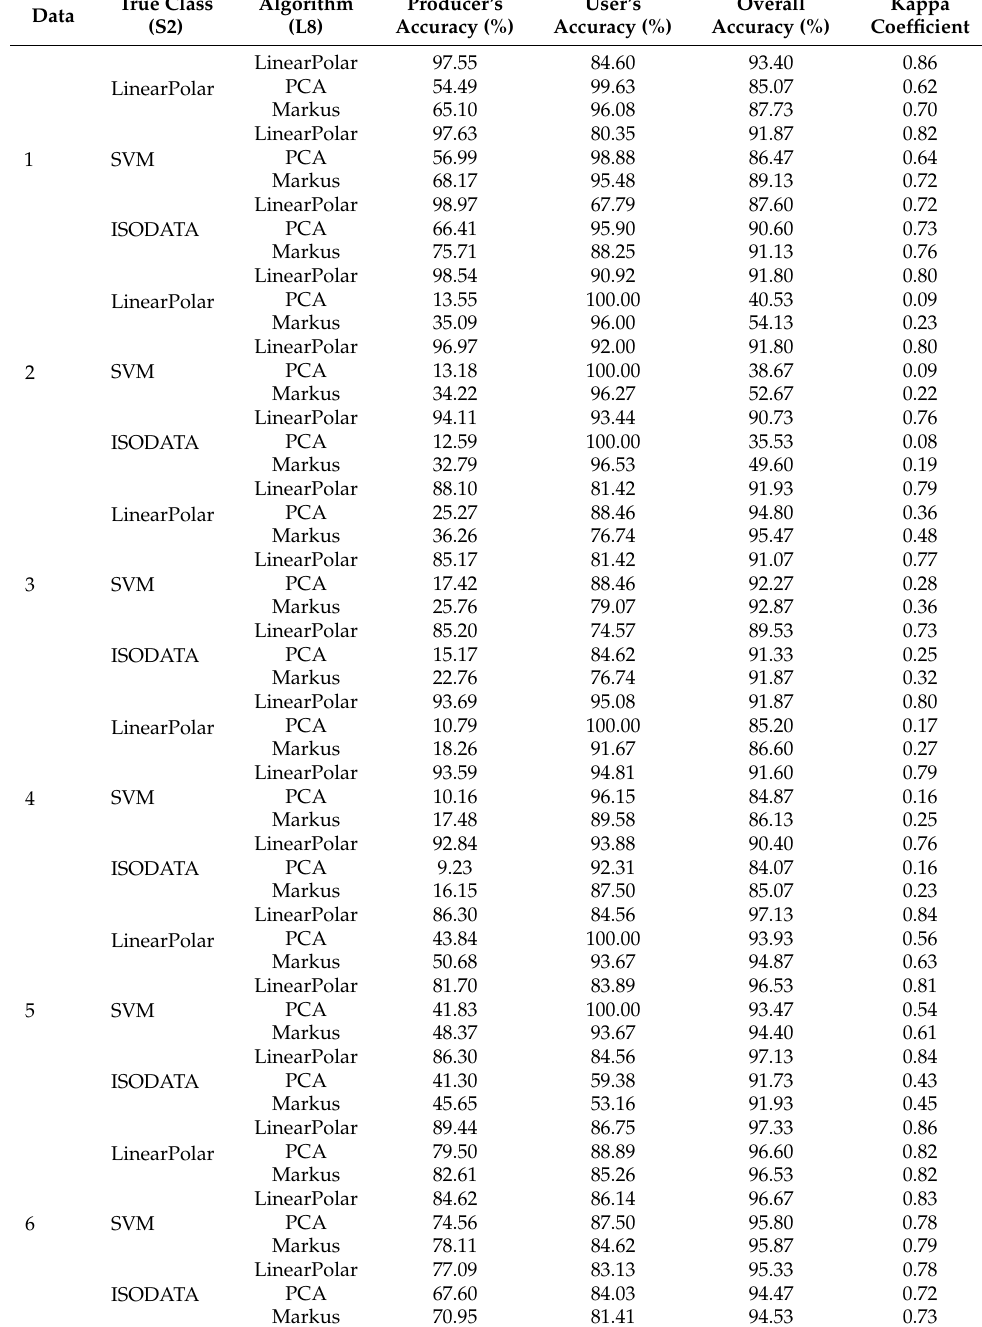
Table 6. Quantitative comparison of the results of different algorithms with 3 validation